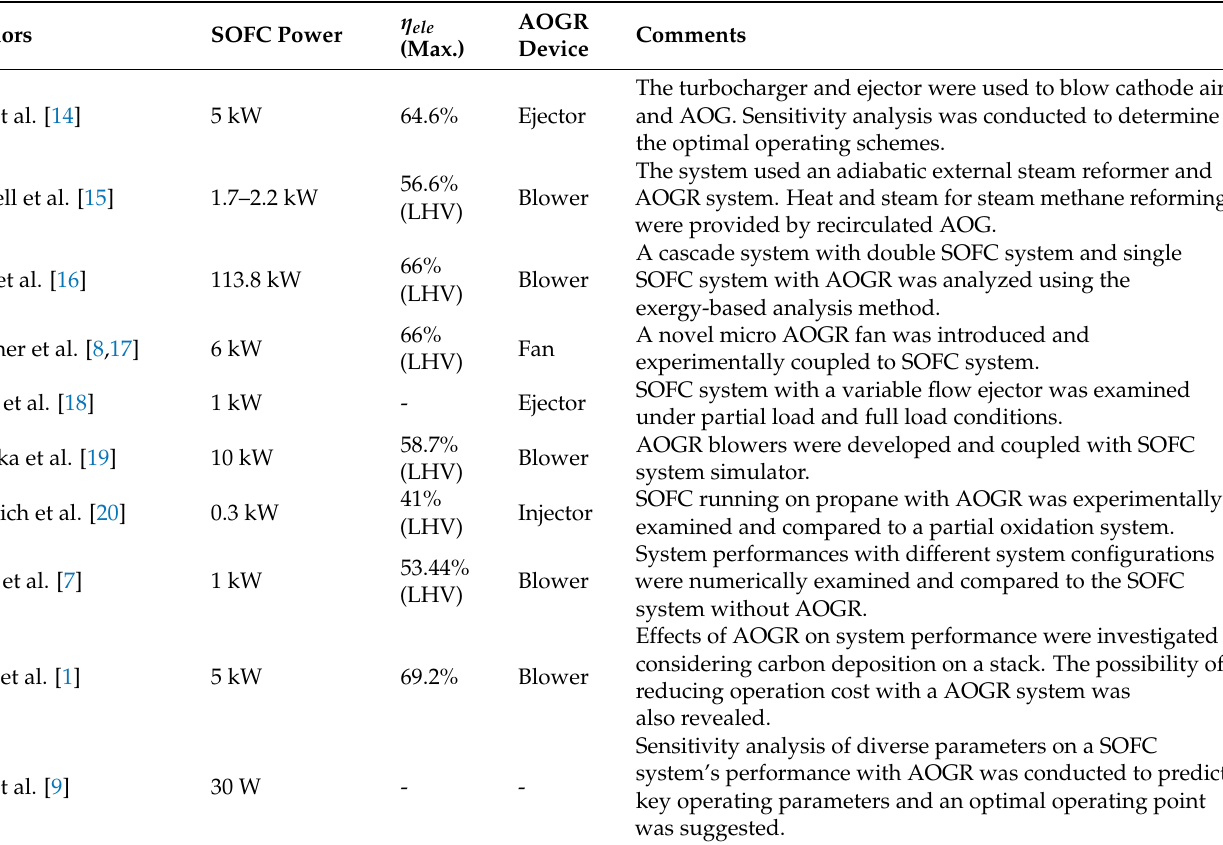
Table 1. A literature summary of the solid oxide fuel cell (SOFC) system with anode off-gas recircula- tion (AOGR) (revised based on the Table 1 in ref.